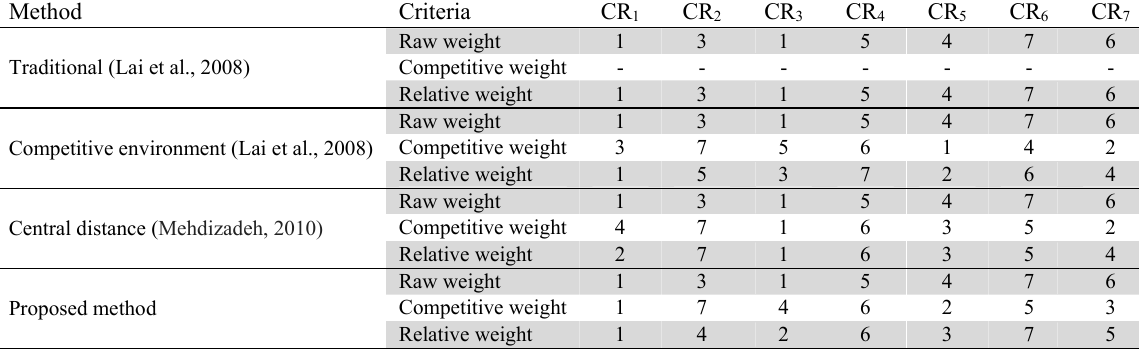
Ranking the customer demands to considering the criteria of raw weight, the competitive weight and the relative weight using the different